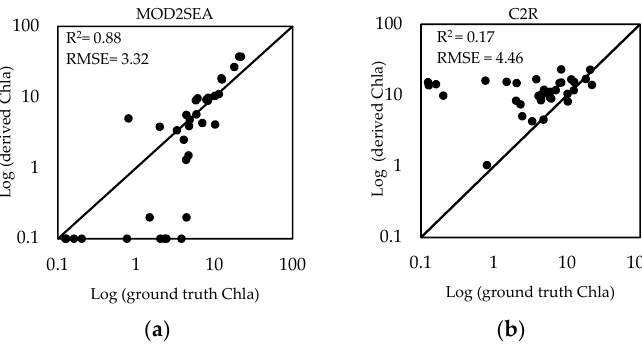
Figure 7. Comparison between MERIS-derived and measured log Chla (mg·m − 3 ) for 35 matchup moments. ( a ) MOD2SEA and ( b ) C2R.